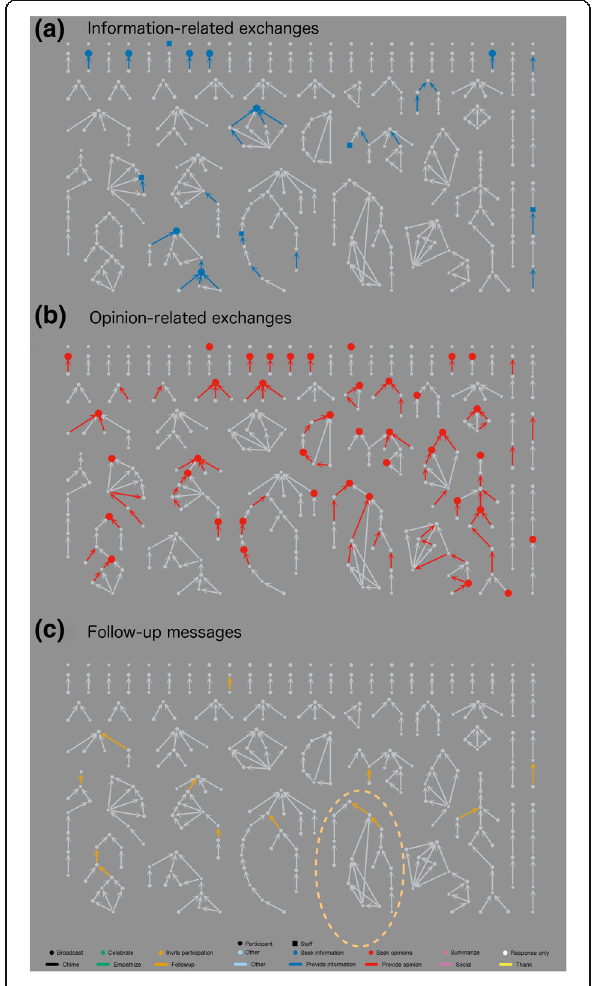
Fig. 7 Network diagrams highlighting a information - related exchanges, b opinion-related exchanges, and c “ follow-up ”